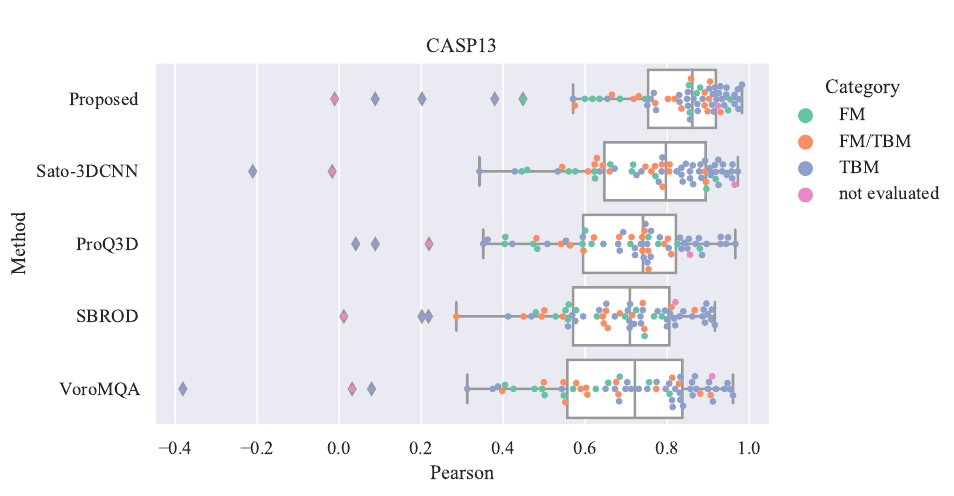
The first column represents the method name. The columns 2 show the average Pearson correlation coefficients for targets in category FM. Columns 3 and 4 similarly represent the values for targets in category FM/TBM and TBM, respectively. The values in parentheses are the p -values calculated by the Wilcoxon signed-rank test for the difference between the proposed method and the comparison method. The best values and p -values smaller than 0.01 are shown in bold. The distribution of the Pearson correlation coefficient for each target on the CASP13 dataset is shown in Figure A1.